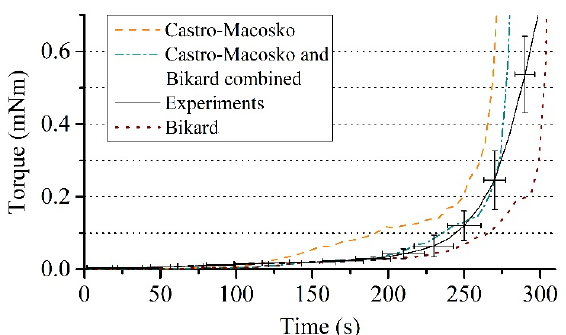
Figure 9. Comparison between the averaged torque measurement curves with standard deviation and